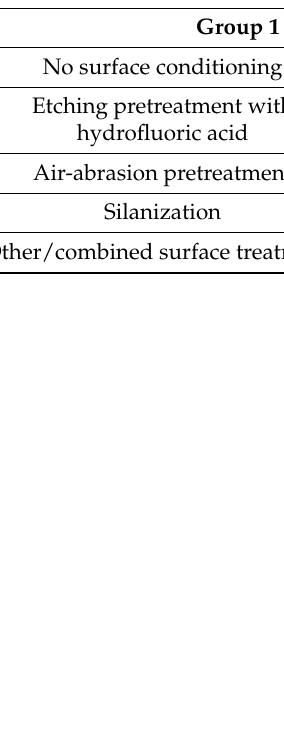
Table 1. Ceramic surface protocol prior to the cementation of prosthodontic restorations. Oxide Ceramics